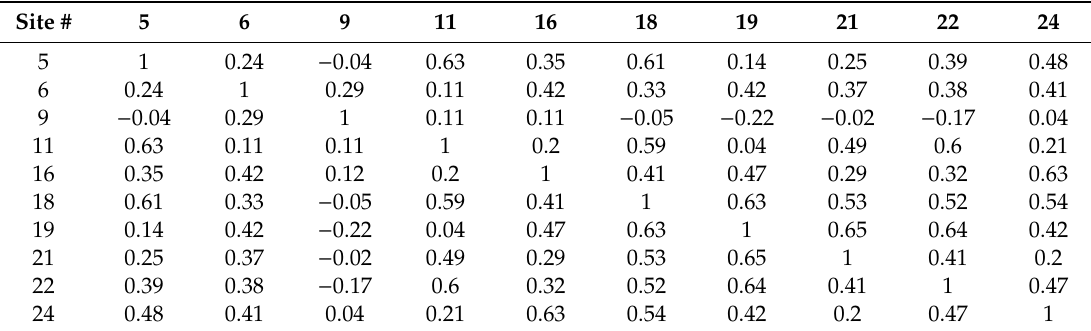
Table 5. Correlation matrix for the selected study